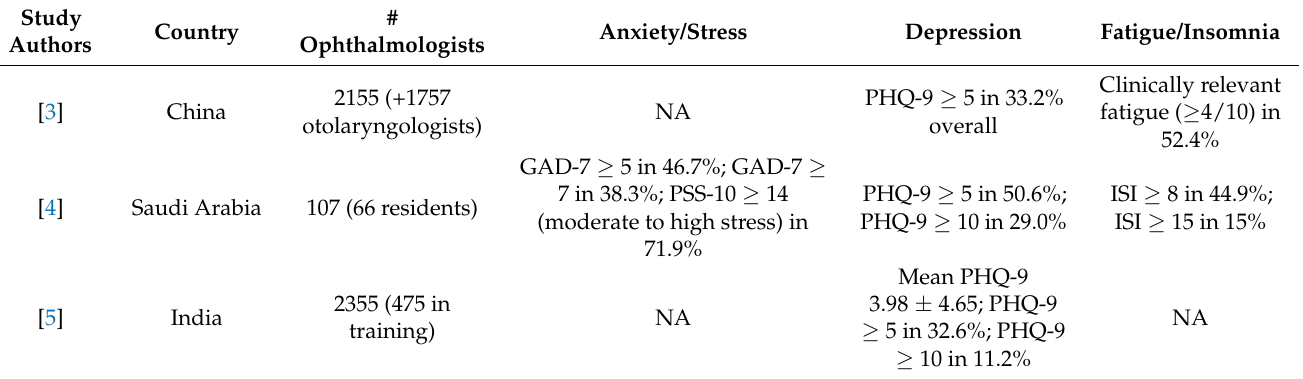
Table 1. Proportions of anxiety/stress, depression, and fatigue/insomnia reported among ophthal- mologists and ophthalmology residents during the coronavirus disease 2019 (COVID-19) pandemic in each survey study included in the review ( n =